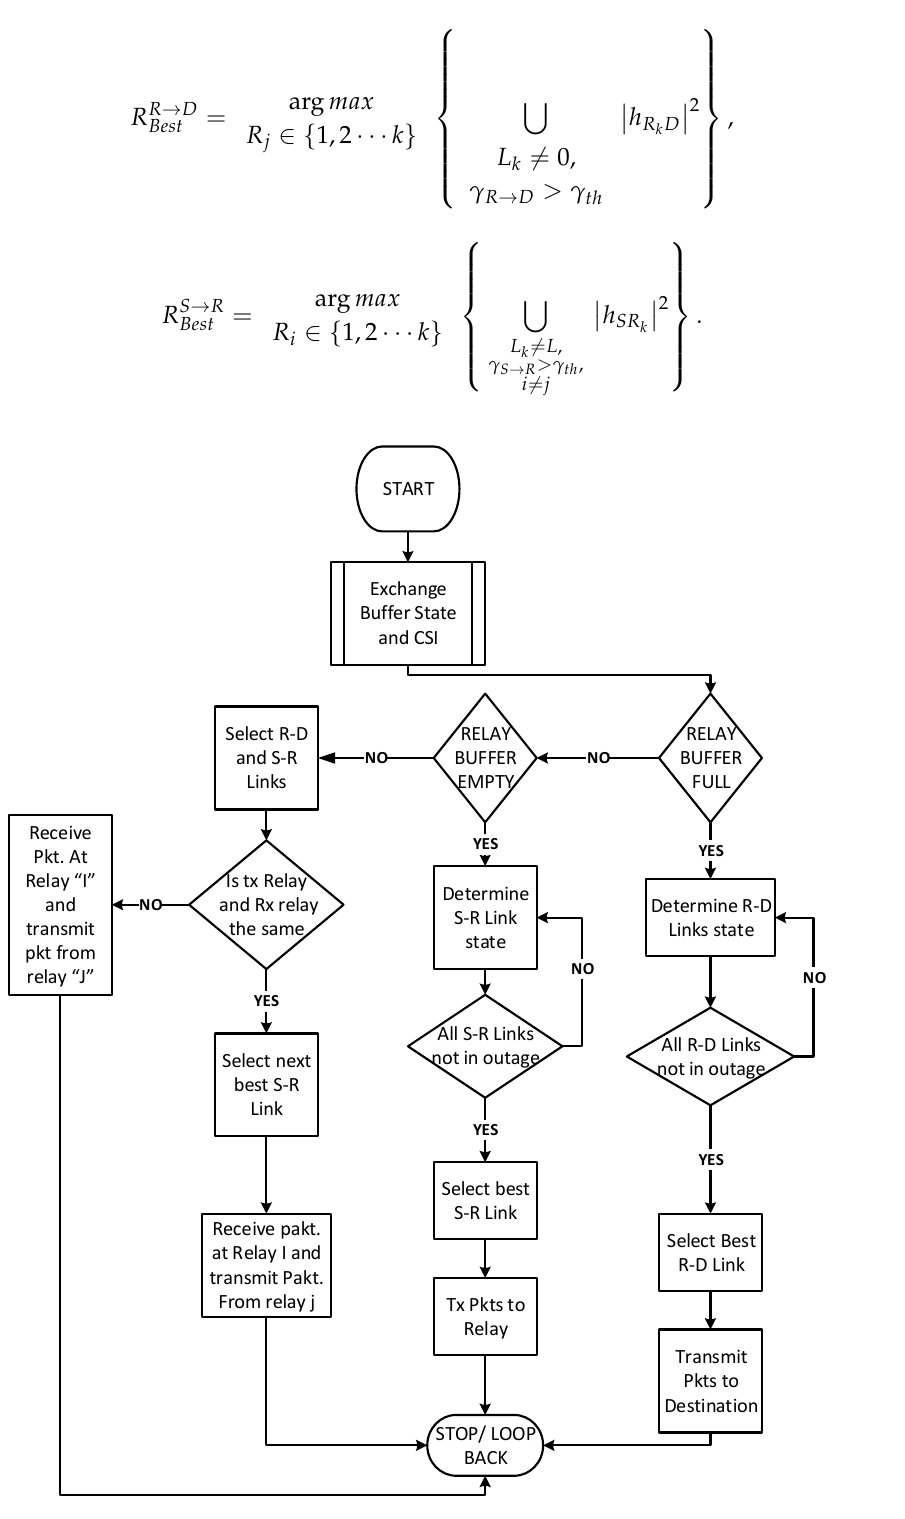
Figure 9. Flow diagram of the relay selection